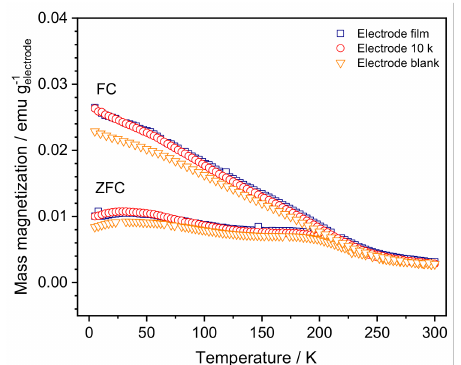
Figure 8. T-dependent FC (field-cooled) and ZFC (zero-field-cooled) mass magnetizations for non- cycled “Electrode film”, cycled electrode “Electrode 10,000”, and non-cycled but soaked in electrolyte “Electrode